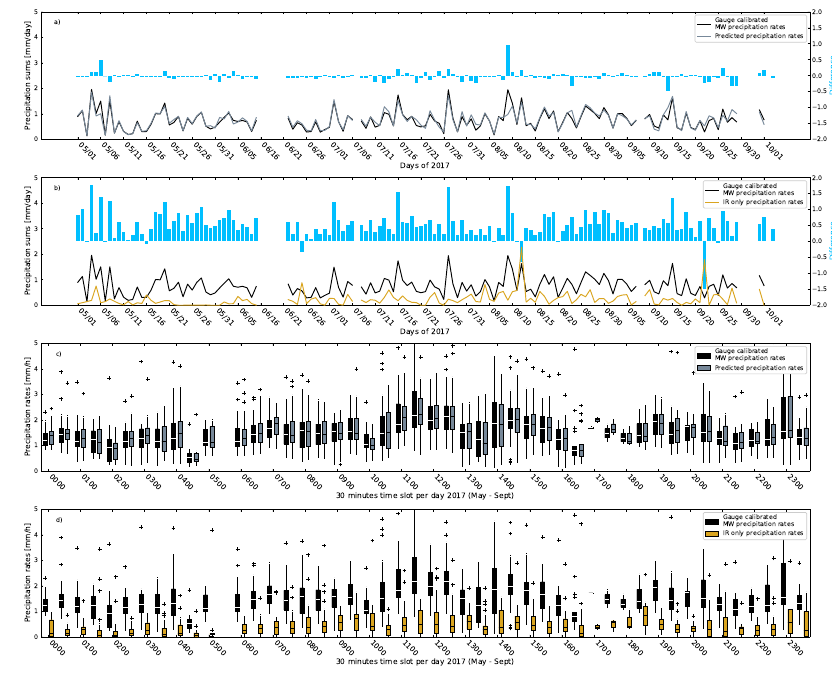
Figure 9. Daily precipitation sums for gauge calibrated MW precipitation rates with the predicted precipitation ( a ) and with IR only precipitation rates ( b ). ( c , d ) depict the gauge calibrated MW precipitation rates, the predicted precipitation rates the IR only precipitation rates on an averaged daily cycle as boxplots. The boxes display the percentiles (25th, 50th and 75th). The whiskers indicate extreme data up to 1.5 times of the interquartile range. Crosses mark outliers. The width of the boxes is relative to the number of validation